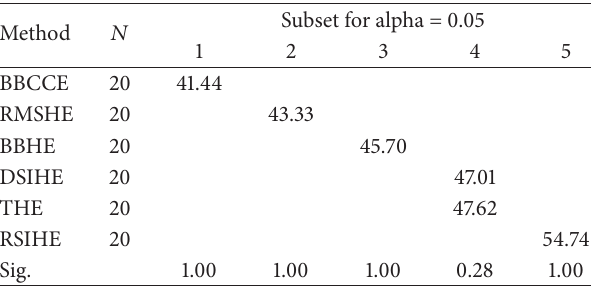
Table 4: Categorization of contrast enhancement methods into homogenous subset using the Duncan test for